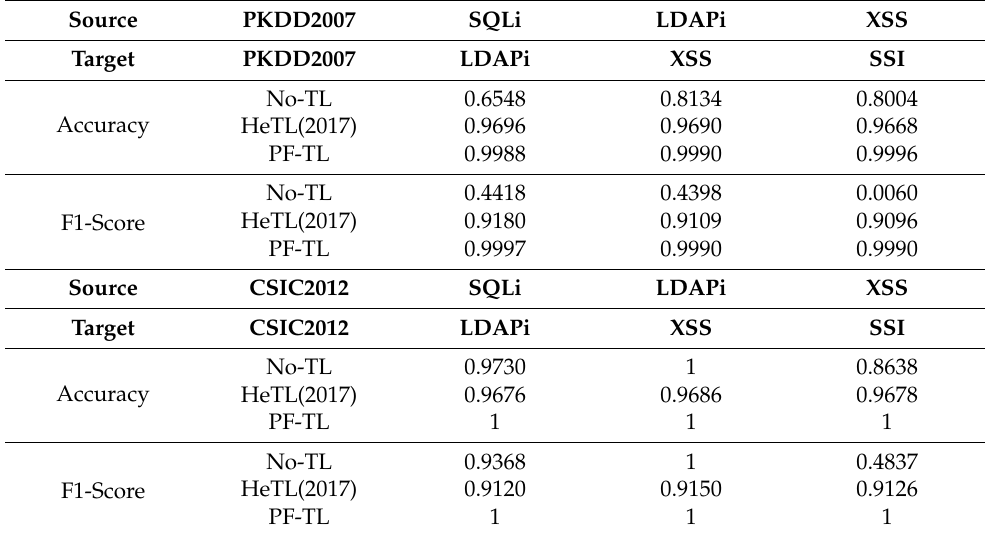
Table 7. Performance comparison of transfer learning on Scenario 1-1.